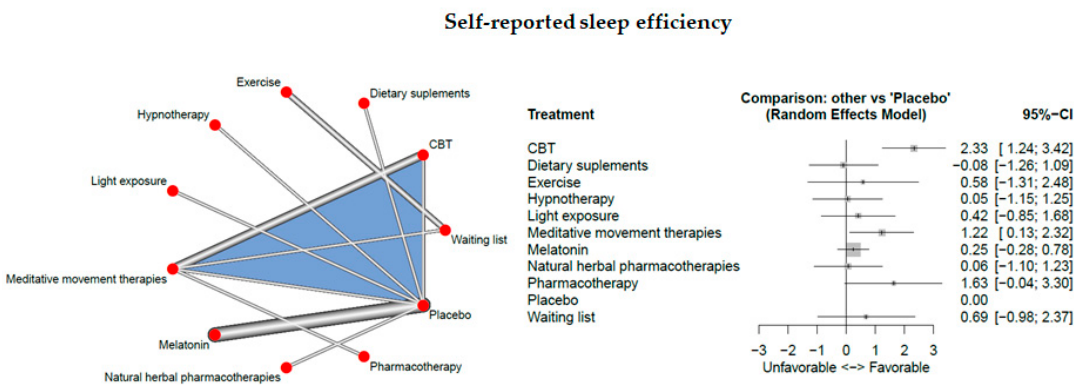
Figure 3. Self-reported sleep e ffi